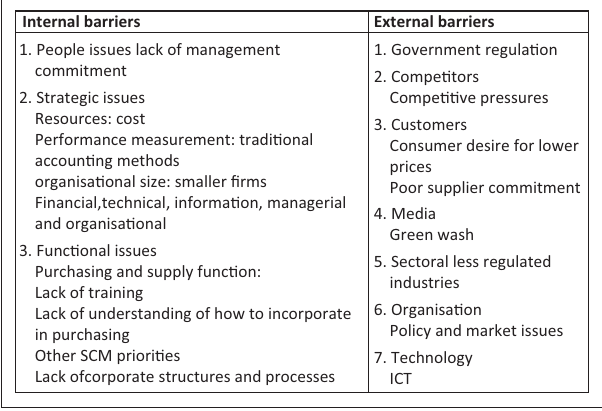
FIG URE 2: Barriers towards sustainable